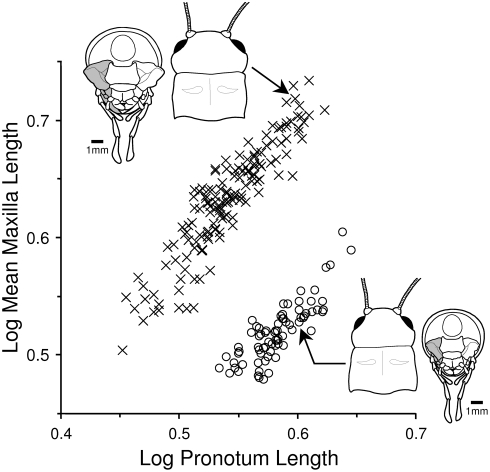
Scatterplot of log mean maxilla length versus log pronotum length showing the sexual dimorphism in mean maxilla length in a sample of 151 males (X) and 75 females (O).Drawings are of a representative male (upper left) and female (lower right) showing the dorsal view as in Fig. 1a as well as the posterior view of the ventral surface of the head (left maxilla is shaded grey as in Fig. 1b). Arrows point to the individuals whose measurements are depicted. Drawings by Janice J. Ting.